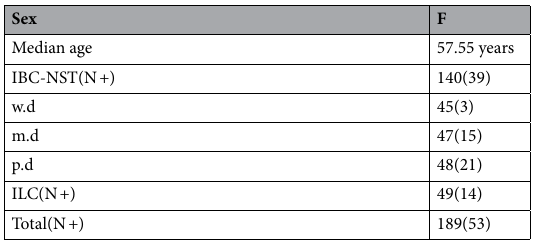
Table 2. Patients selection: sex, median age and distribution of different subtypes of IBC. F female, y years, IBC-NST invasive breast carcinoma of no special type, N + number of cases with lymph node metastasis, w.d. well differentiated, m.d. moderately differentiated, p.d. poorly differentiated, ILC invasive lobular